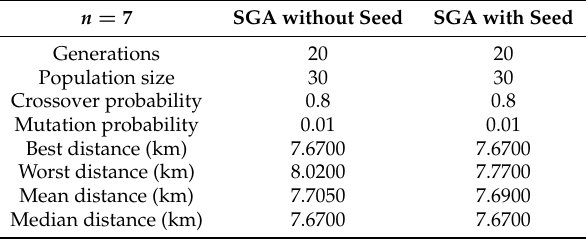
Table 9. Results of 10 executions n = 7 problem, SGA.